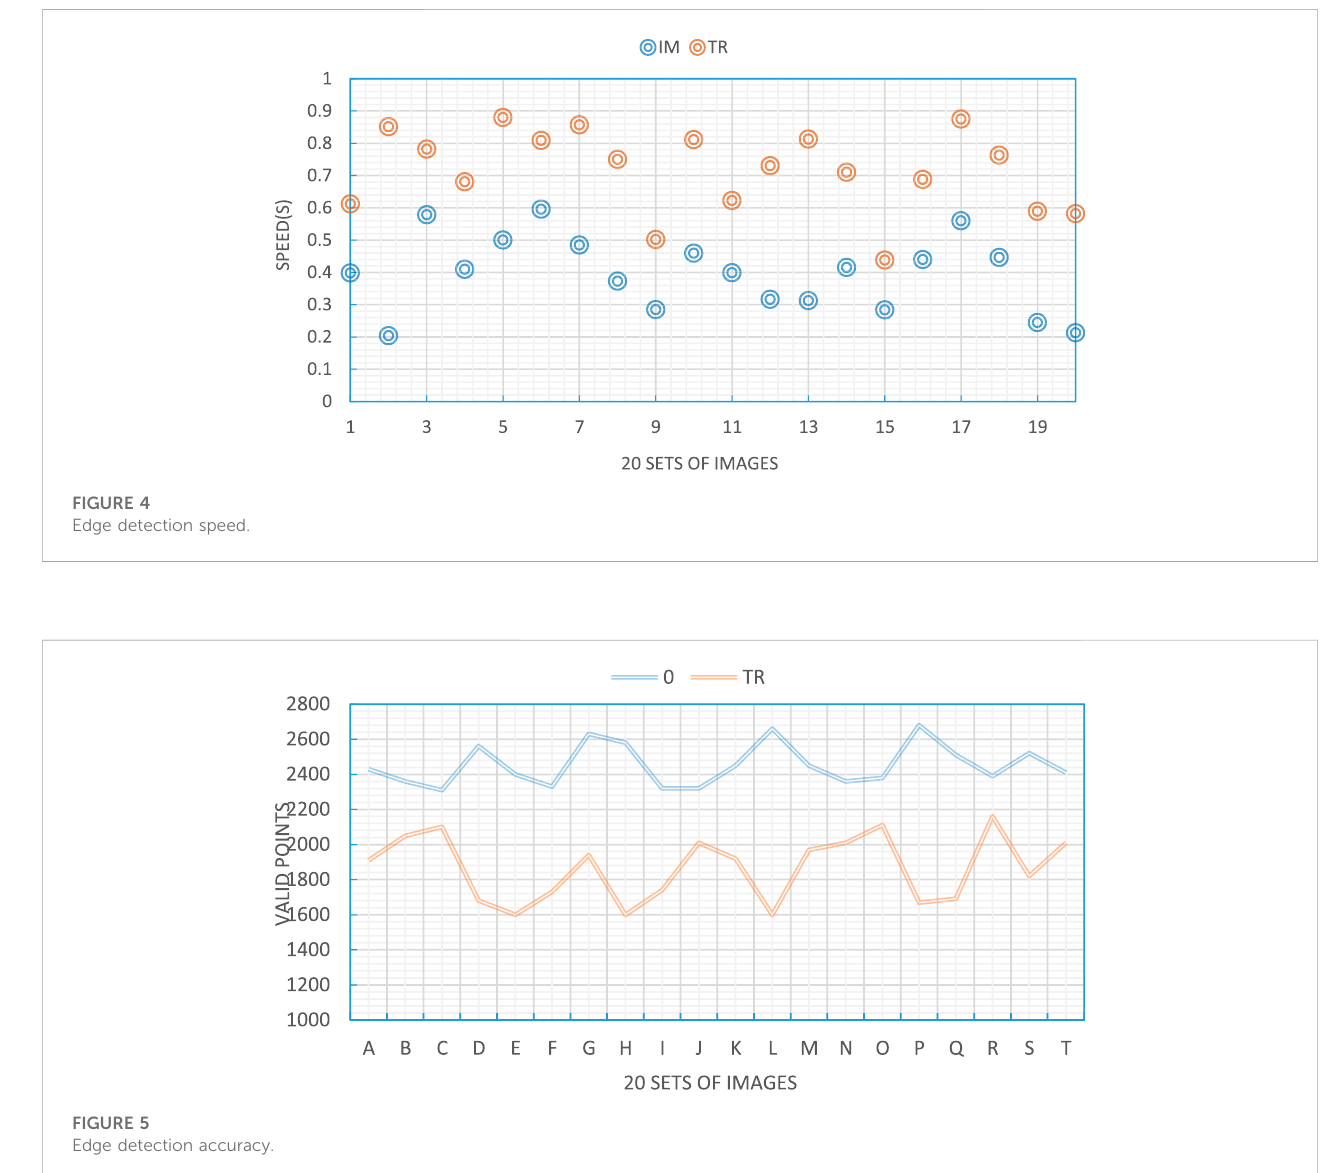
Figure 4 re fl ects the edge detection speed comparison of the two algorithms. The edge detection speed of the improved IM algorithm is the same as the theoretical inference. Compared